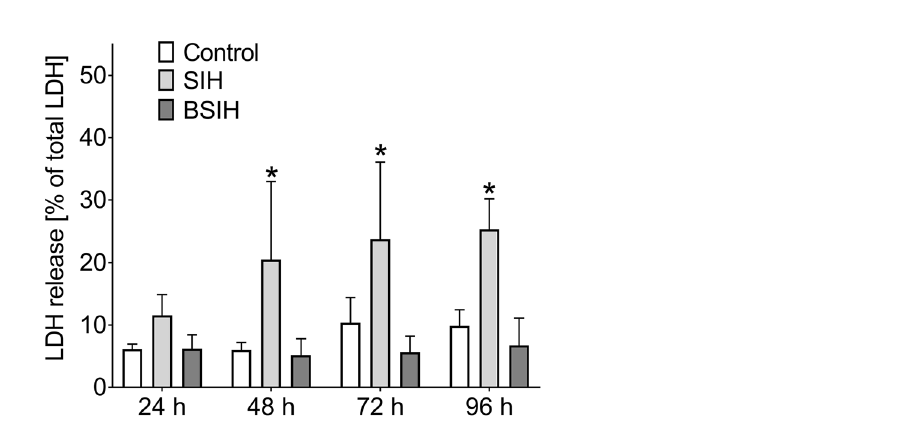
Figure 6. Comparison of cytotoxic effects of Fe chelator SIH and prochelator BSIH in differentiated PC12 cells. Cellular toxicities were determined using LDH activity assay and expressed as a percentage of the LDH released from completely lysed control cells. Time-dependency of cytotoxic effects of SIH and BSIH, both 100 µM, following incubations for up to 96 h with cells. Data are presented as means ± SD ; n = 4; Statistical significance (ANOVA, p ≤ 0.05): * vs. control